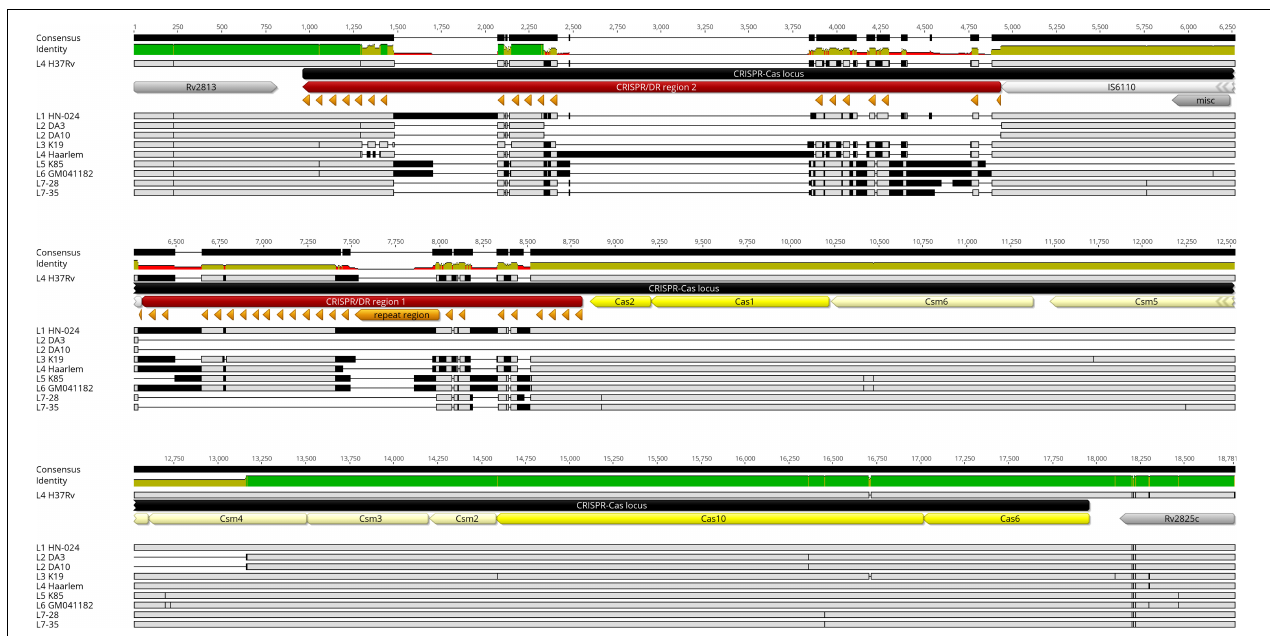
FIGURE 8 | Shows multiple genome alignment of all lineages using Geneious Prime software. The analysis focuses on CRISPR-CAS locus in the following order: CRISPR-Cas region 2, IS6110 (mobile element), CRISPR-Cas region 1, Cas2, Cas1, Csm6, Csm5, Csm4, Csm3, Csm2, Cas10, and Cas6. The Rv2813 and Rv2825c that flank the CRISPR-Cas locus are included in the alignment as reference points. As shown, lineage 2 (ID no. DA 3 and DA 10) have deletion of most the CRISPR repeats. Both Cas 1 and 2, and Csm6 - Csm4 (half of Csm4 is deleted). Cas 10 and Cas 6 seem to be highly conserved among the lineages. SNPs have been observed (black horizontal lines). The size of SNPs in Lineage 7 strains (ID L28 and L35) seems smaller than in other